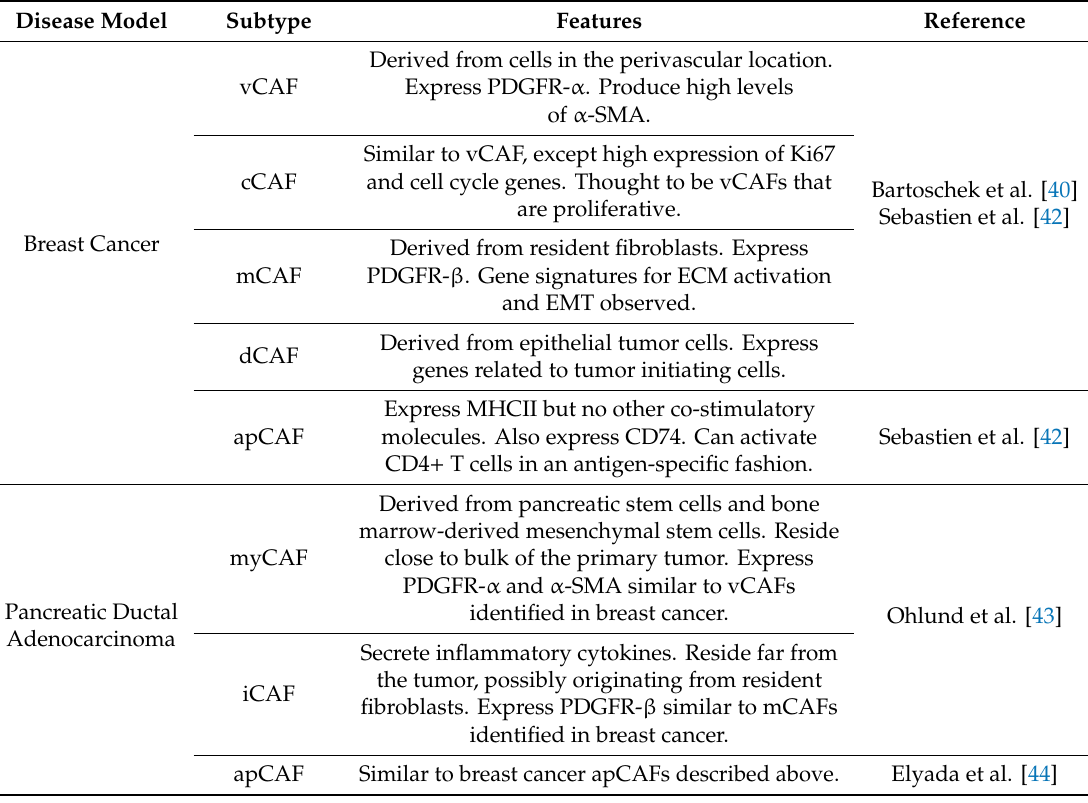
Table 1. Summary of cancer-associated fibroblast (CAF)